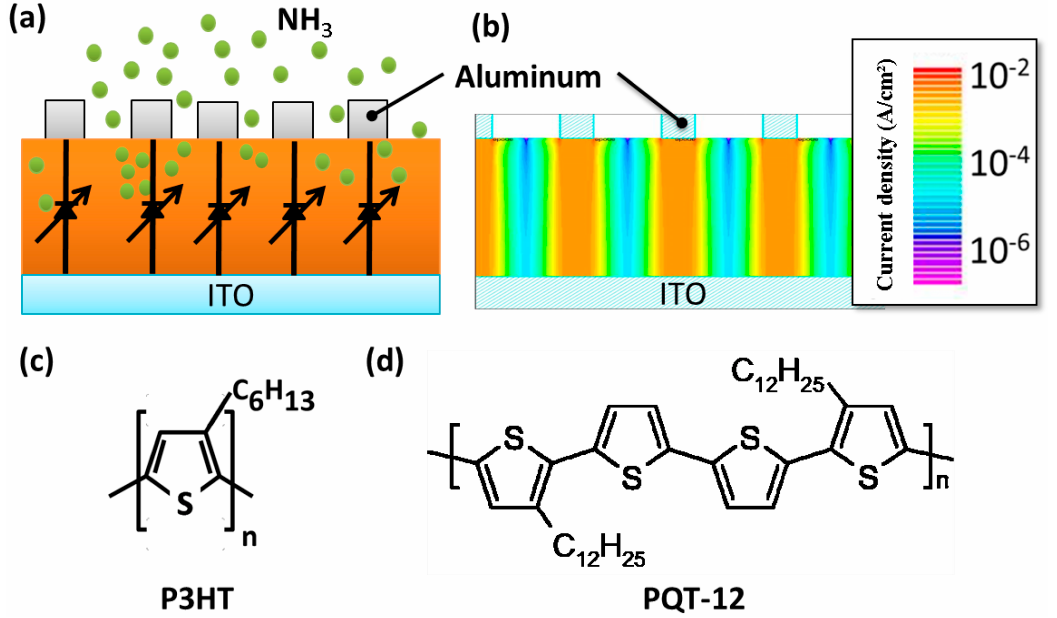
Figure 1. ( a ) The structure of the polythiophene vertical nanometer junction (VNJ)-diode; ( b ) the simulated current distribution of the poly(3-hexylthiophene) (P3HT) VNJ-diode. The molecular structures of ( c ) P3HT and ( d ) poly[5,5'-bis(3-dodecyl-2-thienyl)- 2,2'-bithiophene]